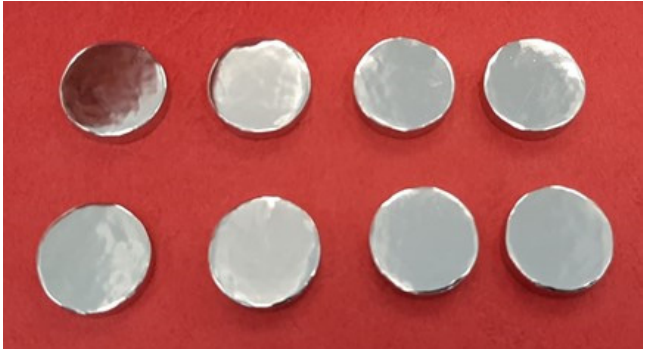
Figure 1. Macroscopic images of the samples obtained from the two types of Co-Cr alloys.